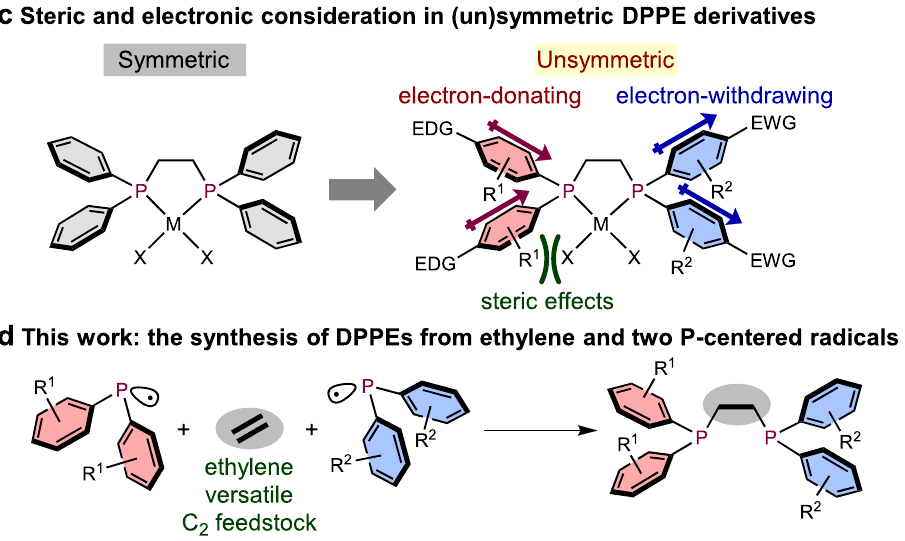
Fig.1|Syntheticstrategiesandthedesignof(un)symmetricDPPEs.a Synthesis of symmetric and b unsymmetric DPPE derivatives. c Steric and electronic con- siderationsin(un)symmetricDPPEderivatives.EDGelectron-donatinggroup,EWG